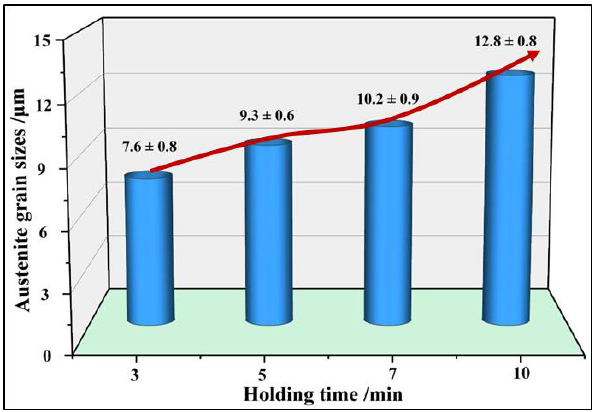
Figure 14. The variation of austenite grain size with different holding time.